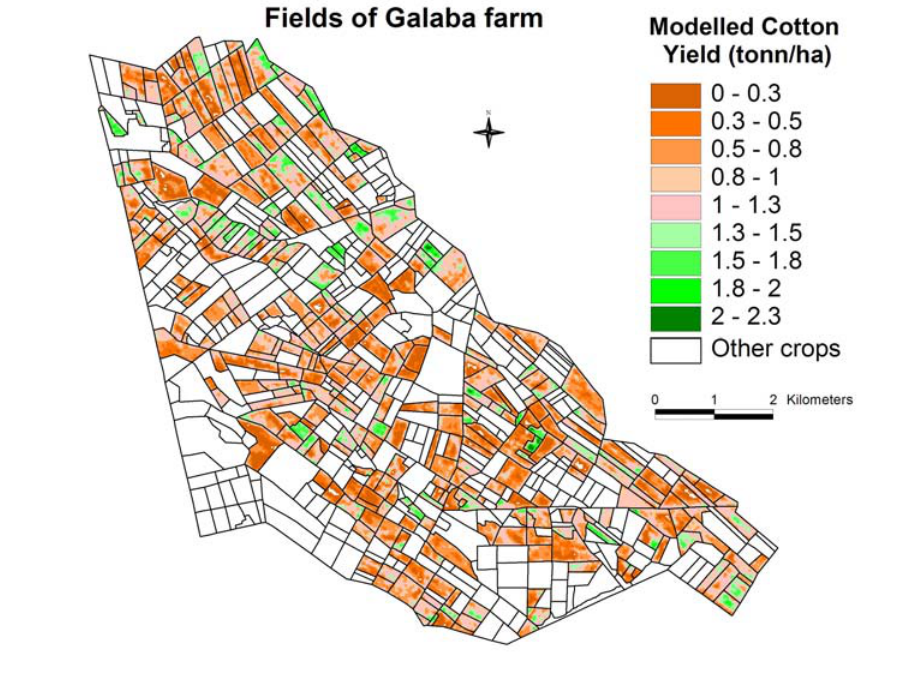
Figure 7. Cotton crop productivity map (CPM) derived from the best NDVI-yield